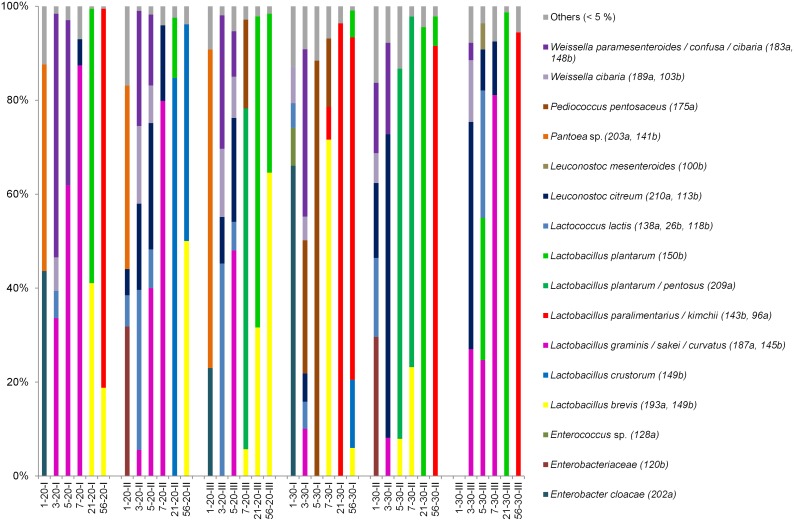
Pyrosequencing of 16S rRNA gene amplicons from spontaneous rye sourdoughs propagated for 56 days.Three sourdoughs were fermented at 20°C (20-I, 20-II, 20-III) and three sourdoughs fermented at 30°C (30-I, 30-II, 30-III). Sourdoughs were sampled at days 1, 3, 5, 7, 21, 56. The relative abundance at the species level based on partial 16S rRNA gene sequences is given. Species forming less than 5% of the population were grouped together and are shown as ‘Others (<5%)’. (a) and (b) stand for two different sequencing runs.